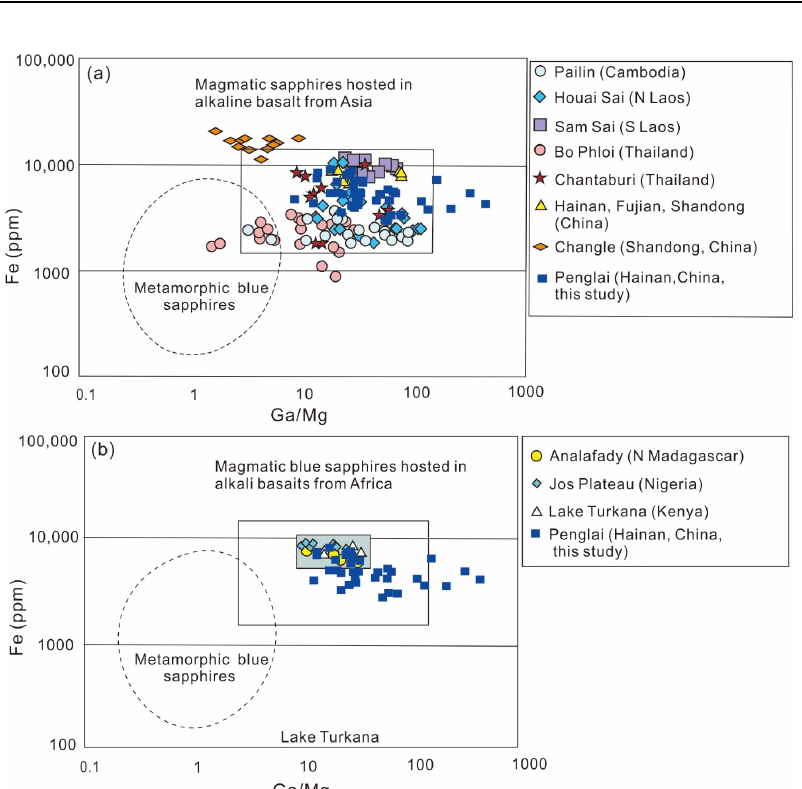
Figure 11. Ga/Mg versus Fe diagram of the magmatic blue sapphires worldwide cited from [38]: ( a ) main Asian field of magmatic blue sapphires hosted in alkaline basalt; ( b ) main African field of magmatic blue sapphires in alkaline basalt.